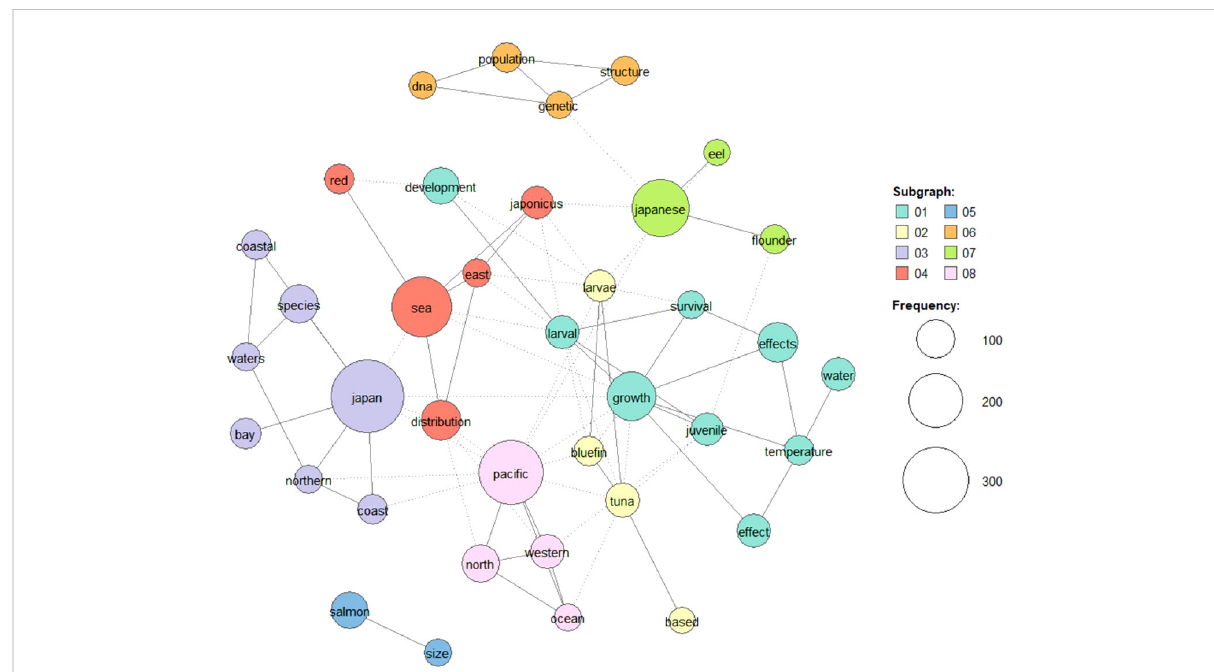
Figure 1 indicates that three of JFRA topic areas, i.e., “ Stock assessment, ” “ Fisheries Oceanography, ” and “ Stock enhancement, ” largely occupy the scienti fi c performance of the organization during the last 15 years. Thus, the combined results indicated that JFRA was a part of fi sheries policy. Both science and policy were inherently based on the fi sheries practices in the “ real world ” in Japan, and it has heavily focused on bio-physical dimensions of fi sheries, represented by such areas as “ Stock assessment ” (subgraph 1, 2, 3, 5, and 8), “ Fisheries Oceanography ” (subgraph 3,4 and 8), “ Stock enhancement ” (subgraph 1, 2, 4, 5, 6, and 7) over the last 15 years Figure 1 and Table